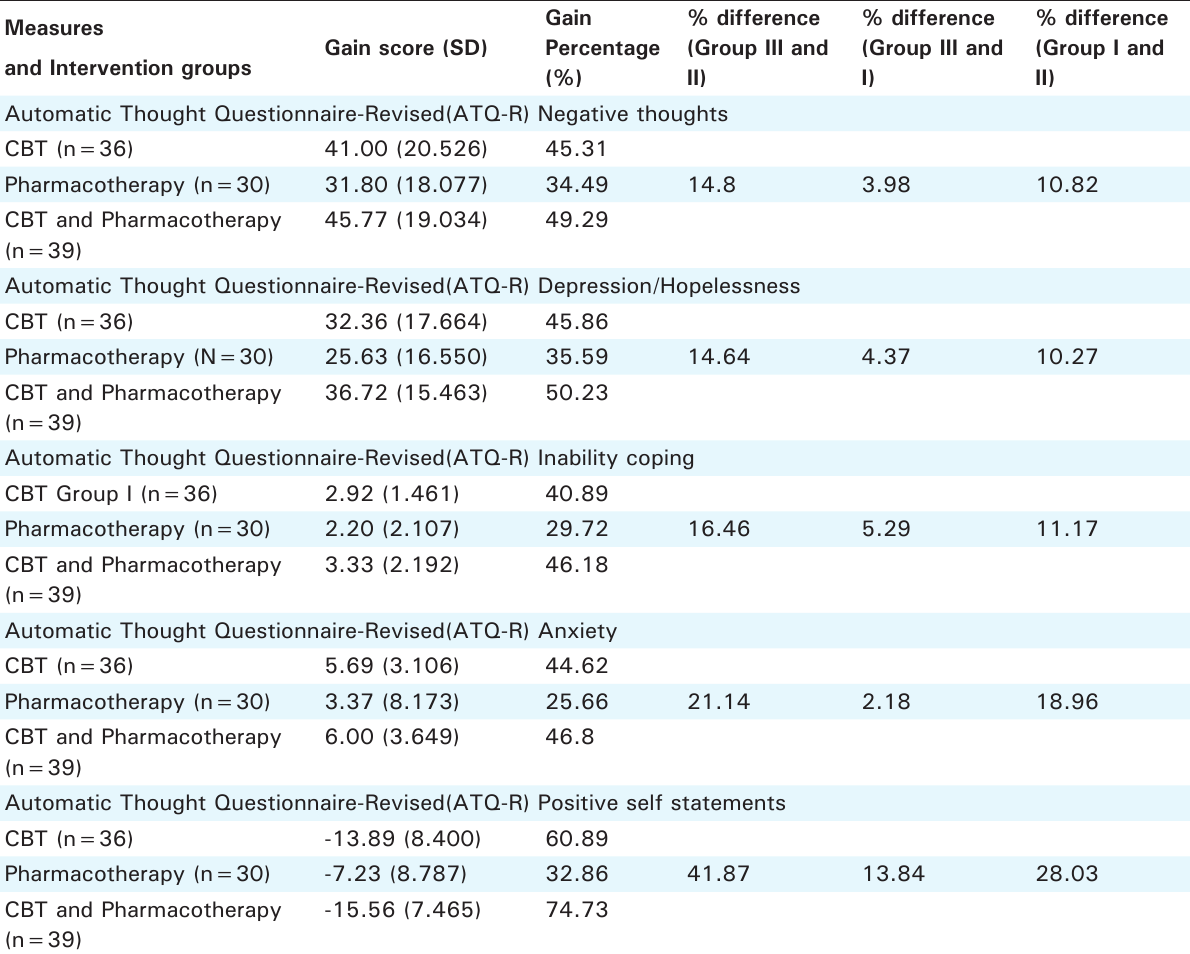
Table 5. Gain scores, gain percentage and percentage difference in ATQ-R among intervention